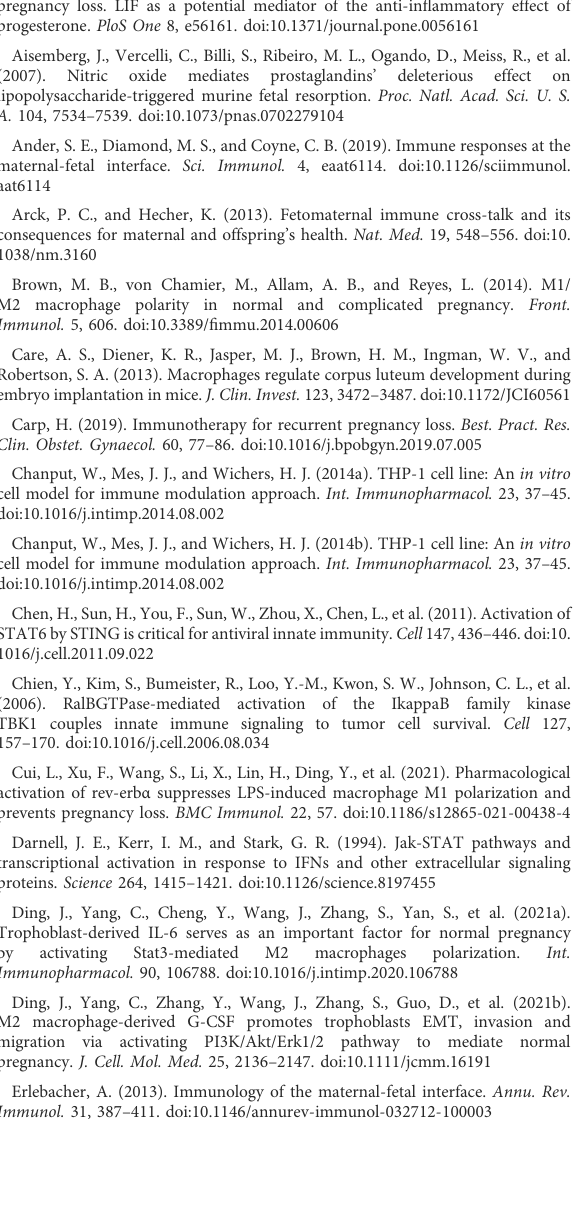
SUPPLEMENTARY FIGURE S6 Expression levels of G-CSF and SEC5 determined by qRT-PCR in THP-1 Ms stimulated with IL-4 and IL-13. NC: M0-Ms transfected with the negativecontrol;siSEC5:M0-MstransfectedwithSEC5-speci fi csiRNA; NC-M2: M0-Ms transfected with the negative control and stimulated with IL-4 + IL-3; siSEC5-M2: M0-M s transfected with SEC5-speci fi c siRNA and stimulated with IL-4 +